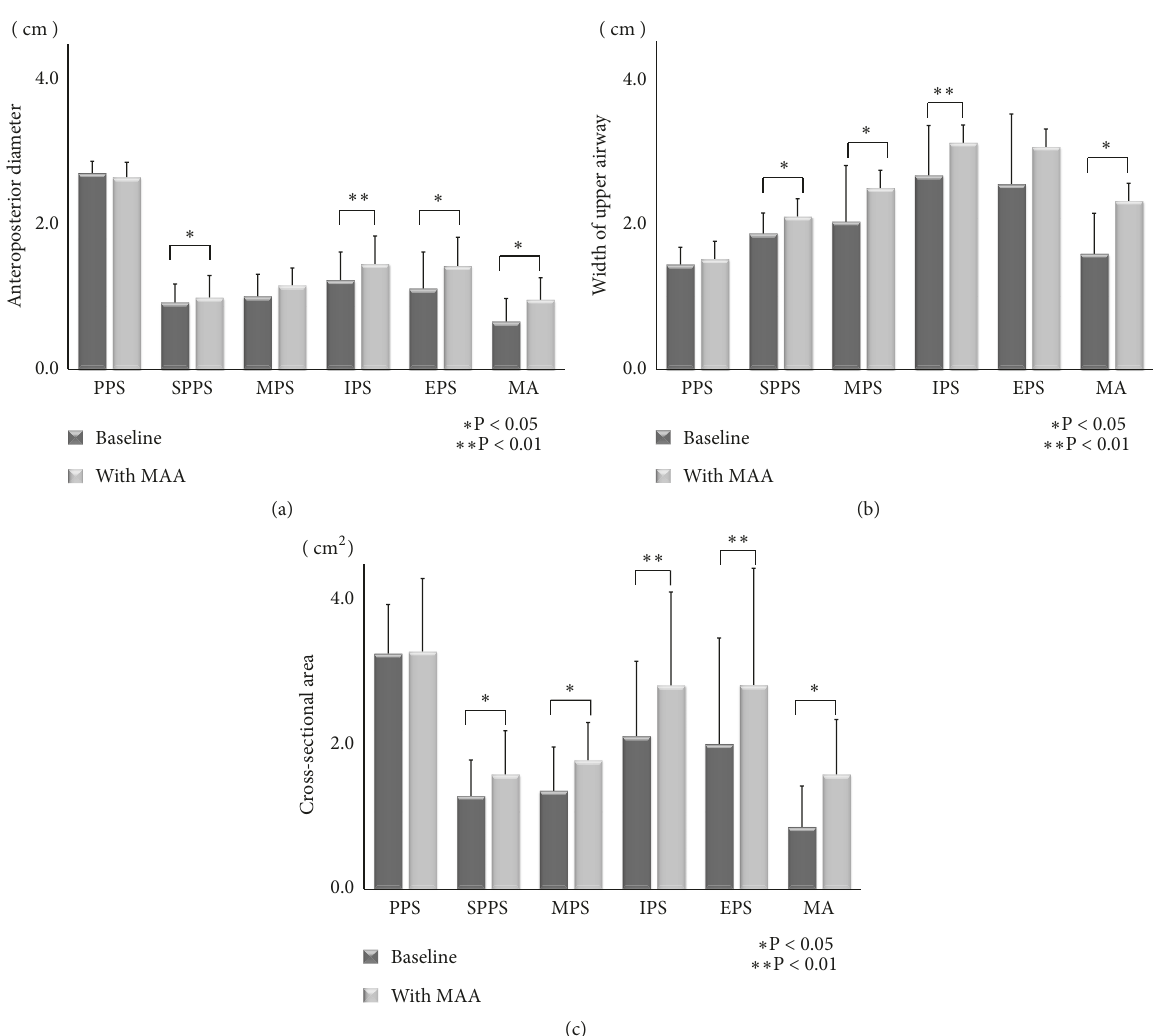
Figure 8: (a) Comparison of the anteroposterior diameters of the six sites between baseline and data with the mandibular advancement appliance (MAA). Abbreviations: EPS, epiglottic pharyngeal space; IPS, inferior pharyngeal space; MA, minimum area; MPS, middle pharyngeal space; PPS, palatal pharyngeal space; SPPS, superior posterior pharyngeal space. (b) Comparison of the widths of the six sites between baseline and data with the mandibular advancement appliance (MAA). Abbreviations: EPS, epiglottic pharyngeal space; IPS, inferior pharyngeal space; MA, minimum area; MPS, middle pharyngeal space; PPS, palatal pharyngeal space; SPPS, superior posterior pharyngeal space. (c) Comparison of the cross-sectional area of the six sites between baseline and data with the mandibular advancement appliance (MAA). Abbreviations: EPS, epiglottic pharyngeal space; IPS, inferior pharyngeal space; MA, minimum area; MPS, middle pharyngeal space; PPS, palatal pharyngeal space; SPPS, superior posterior pharyngeal